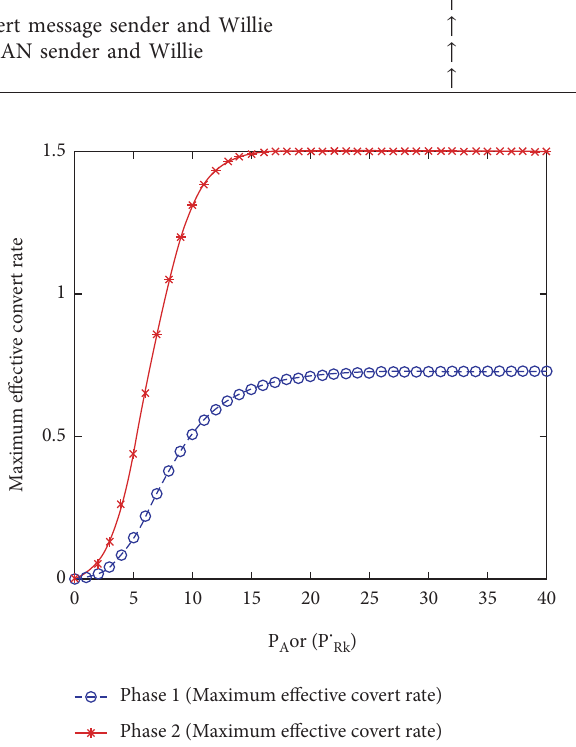
Figure 21: Comparison of stage 1 and stage 2 maximum effective covert rates, where σ 2 N � 3, ε � 0 . 05, | h R